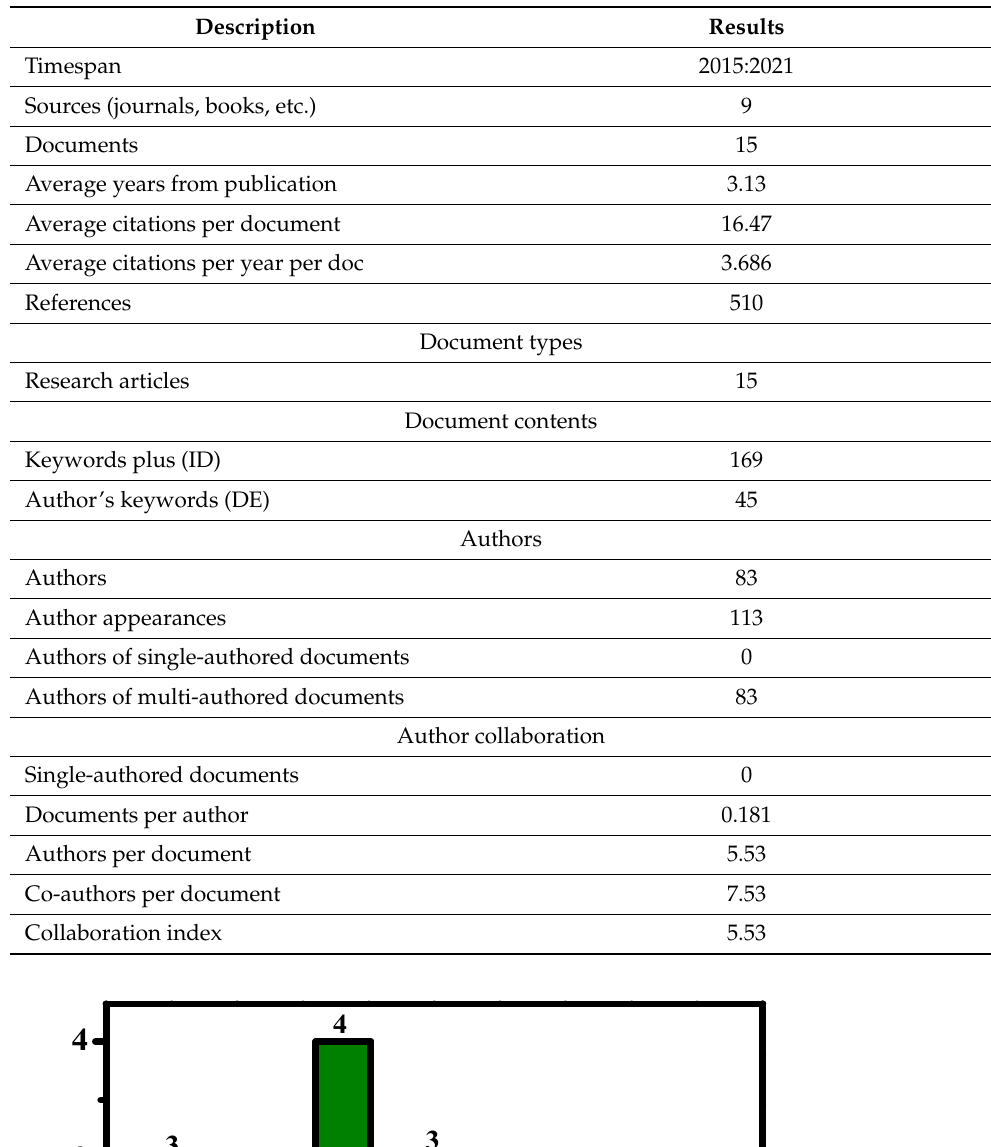
Table 4. Main information obtained from the selected articles.